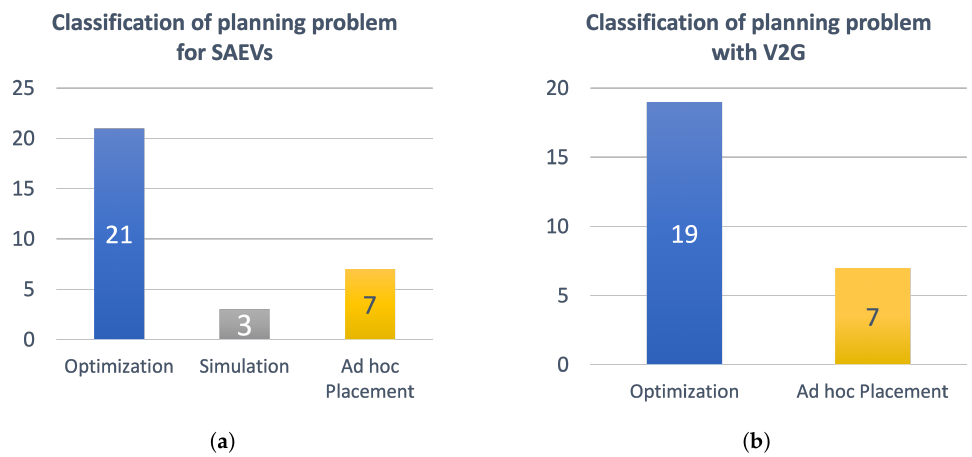
Figure 6. A classification of the methodologies used for the charging infrastructure allocation problem for ( a ) SAEV papers and ( b ) V2G papers. reworked from [1]. (When one paper performs multiple strategies, all strategies are included as input for this chart. Voshoogi et al. [62] and Gacias et al. [63] consider three and two different optimization problems, respectively. Cocca et al. [52] perform ad hoc placement based on three different likelihood variables, and they solve one optimization